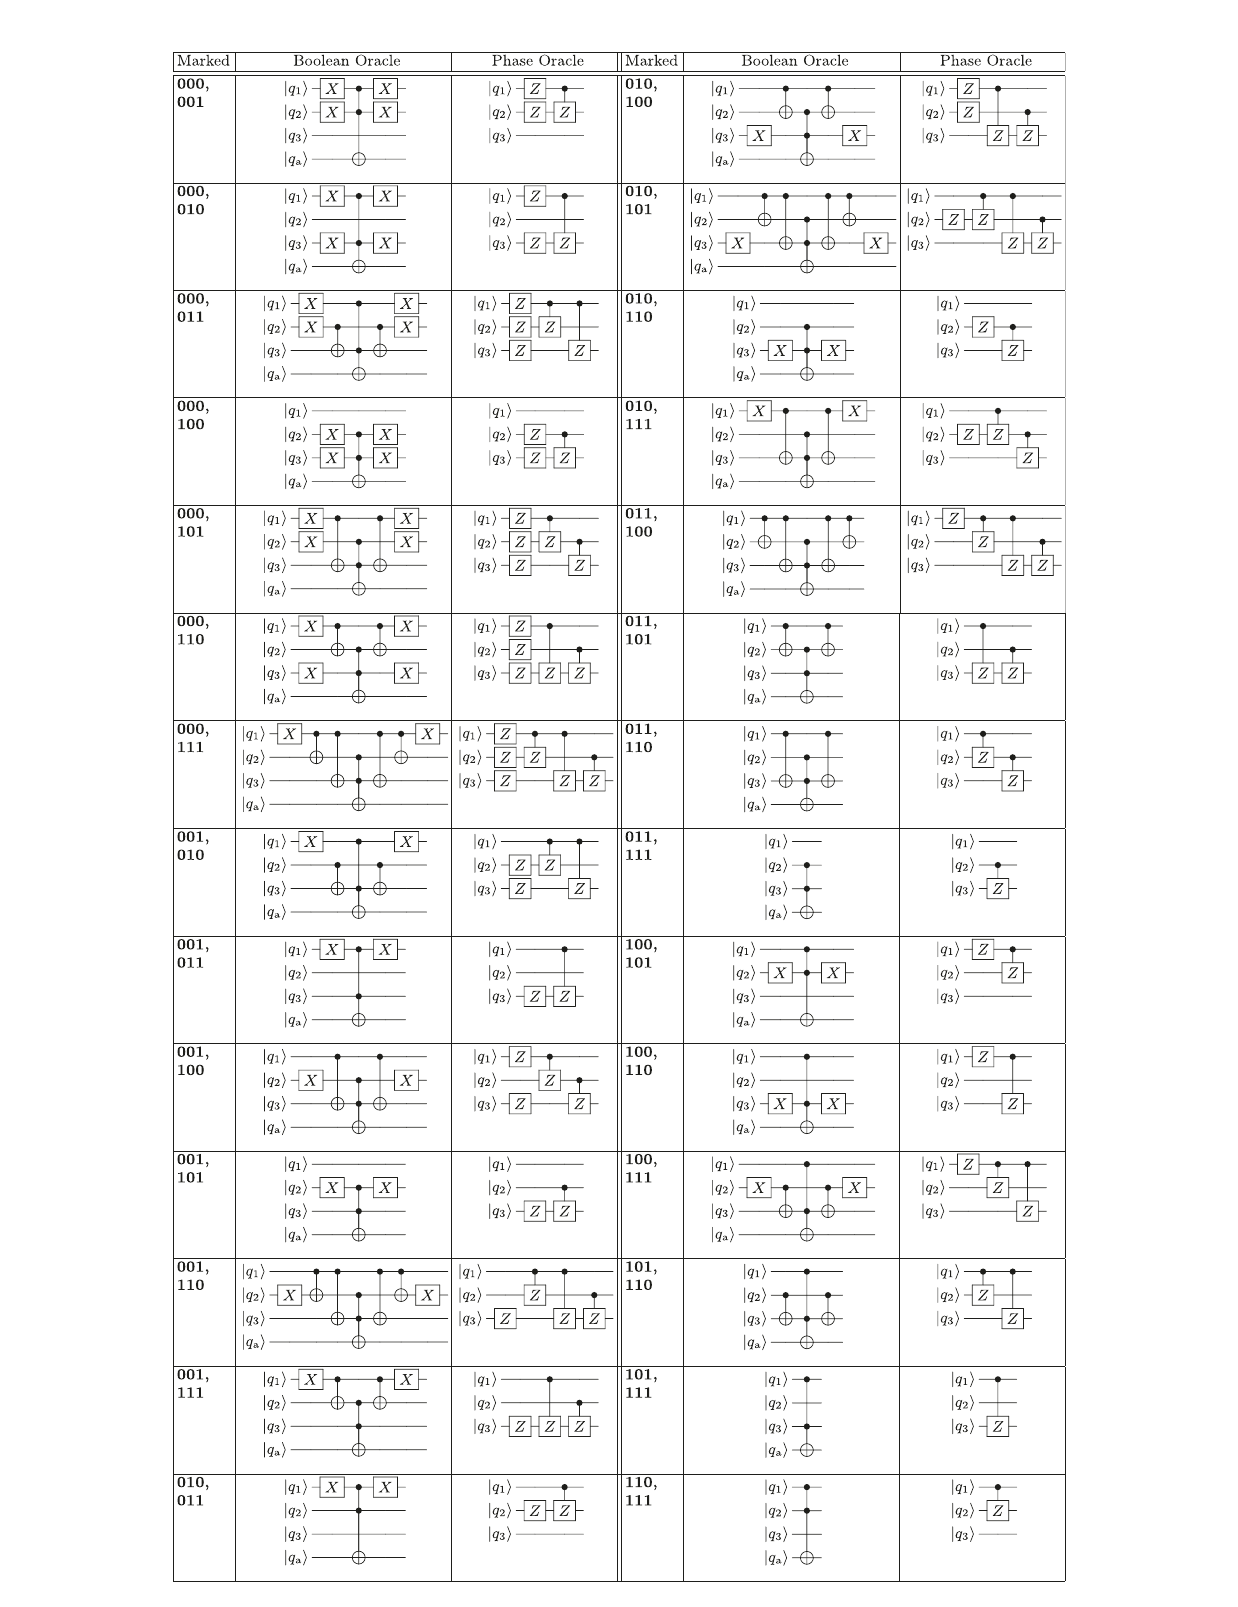
Table of all oracles used for the two-solution Grover search